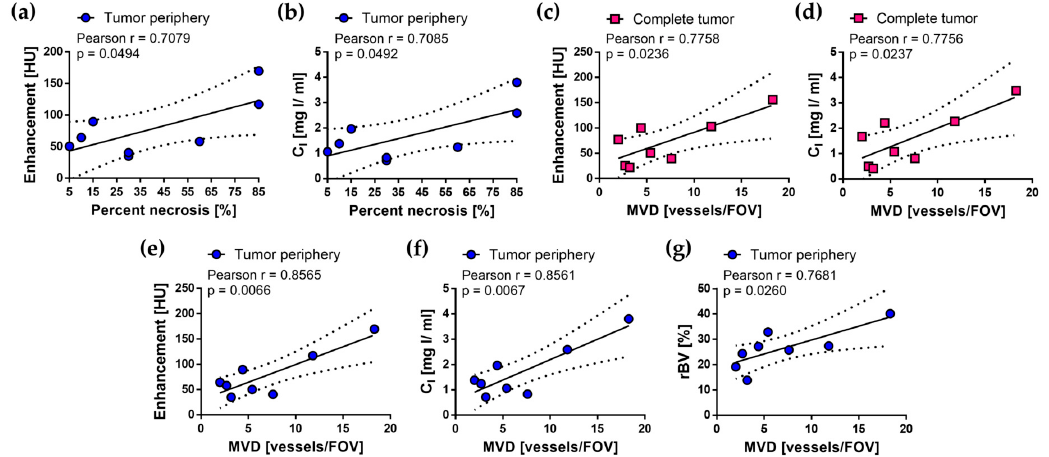
Figure 7. Histological validation of the quantitative imaging parameters from SE images of the subcutaneous C6 glioma model. Strong and significant correlations were found for seven sets of imaging and histological parameters: percent necrosis and ( a ) enhancement and ( b ) C I at tumor periphery; MVD and ( c ) enhancement and ( d ) C I in complete tumor; MVD and ( e ) enhancement, ( f ) C I , and ( g ) rBV at tumor periphery. Pearson r and p -value for each correlation are indicated in the graphs, as well as 95% confidence intervals (dotted